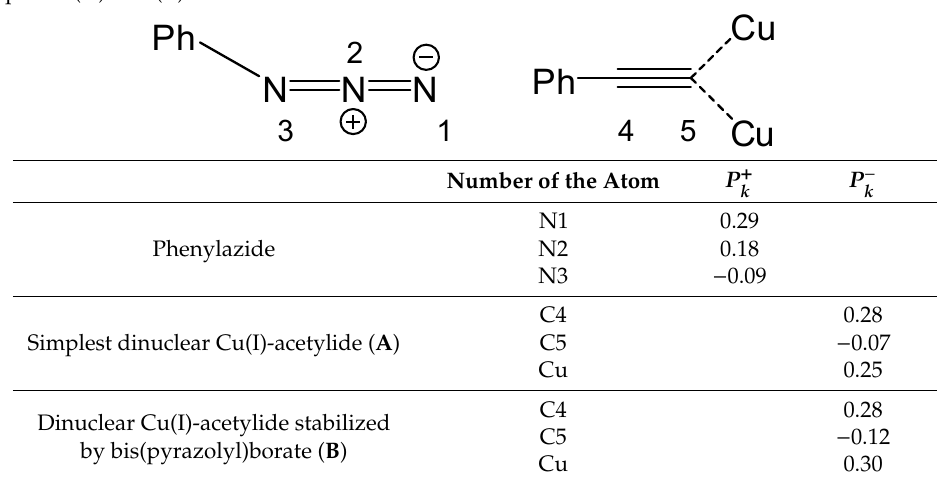
Table 6. Electrophilic P + the complexes ( A ) and ( B ) complexes ( A ) and ( B ).